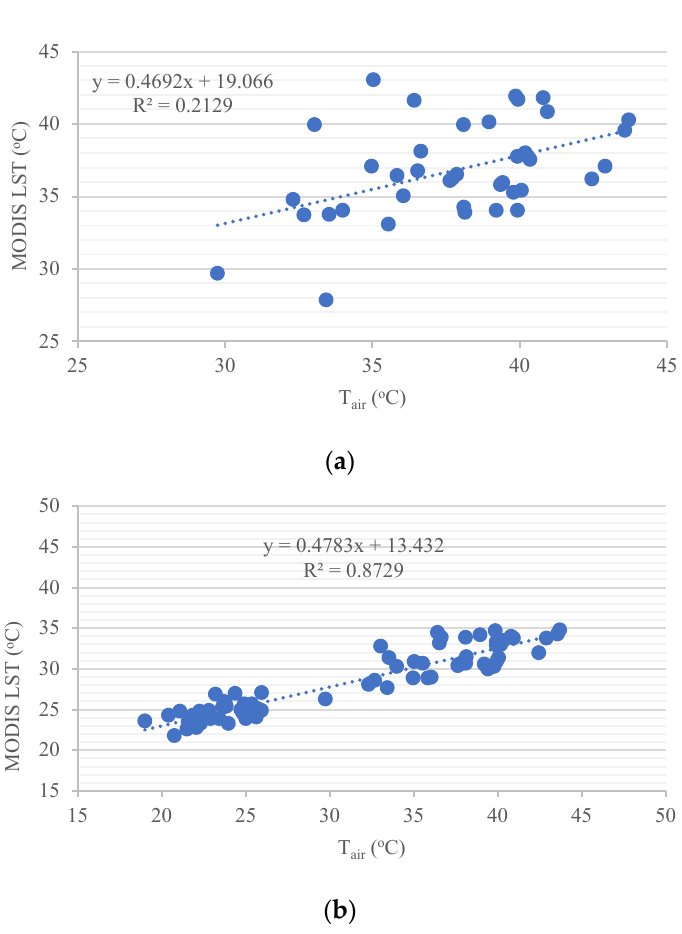
Figure 5. ( a ) Correlation between the MODIS LST and the T air for Test 1. ( b ) Correlation between the MODIS LST and the T air_met for Test 2.